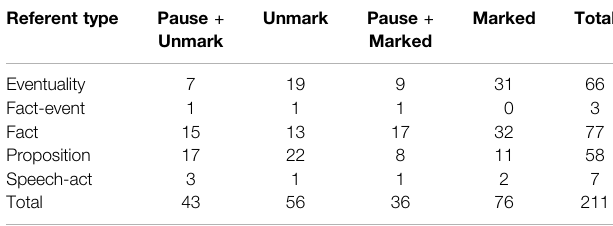
TABLE 2 | Abstract referent types and pronominal types in the DanPass